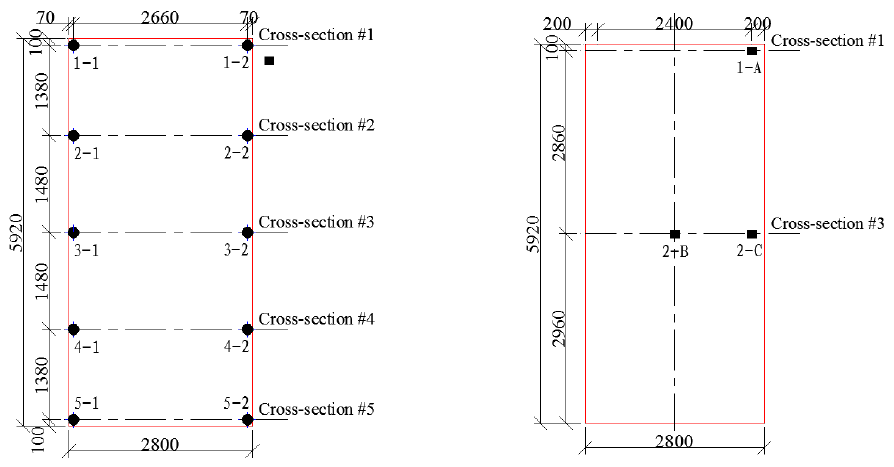
Figure 8. The arrangements of the ( a ) dial gauges and ( b ) pressure measuring sensors.